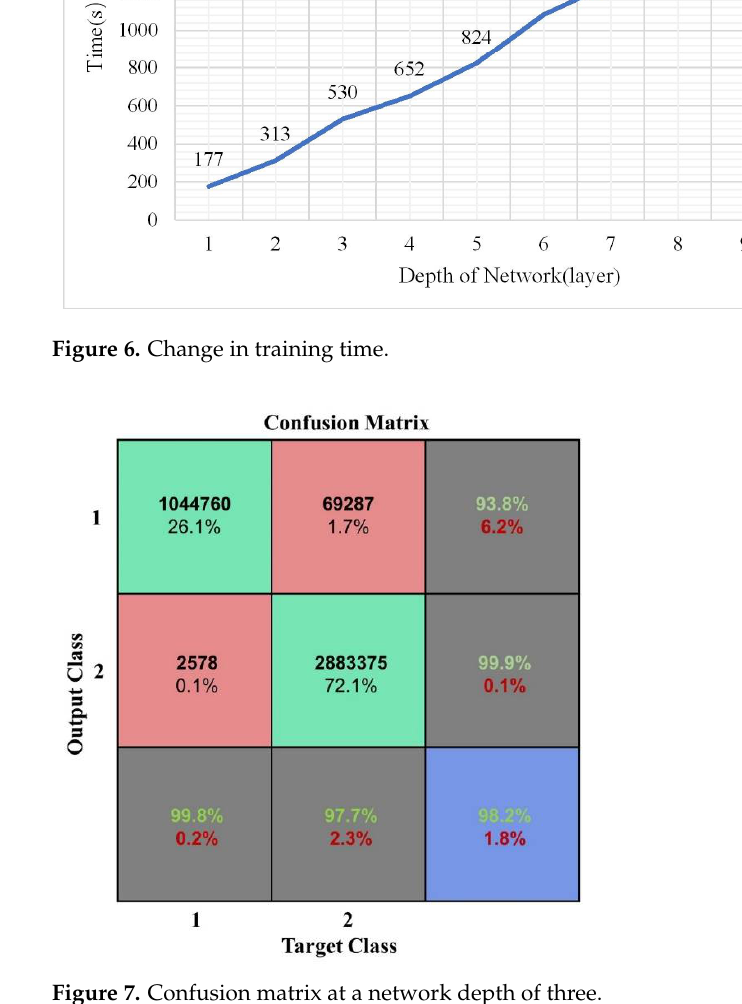
Figure 6. Change in training time.